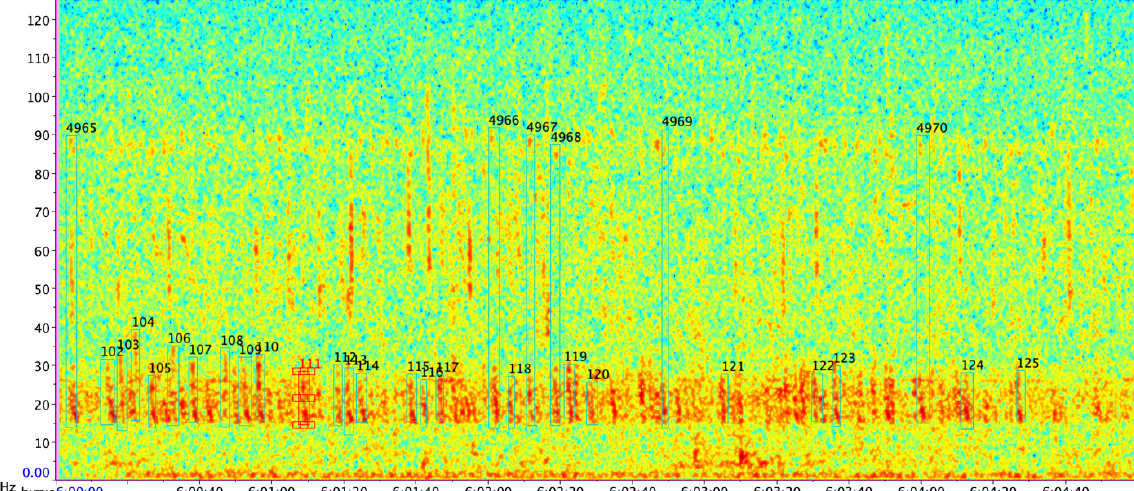
Figure A1. F20P log examples from file 20140222_060000_AWI251-01_AU0231_250Hz for the location Elephant Island.